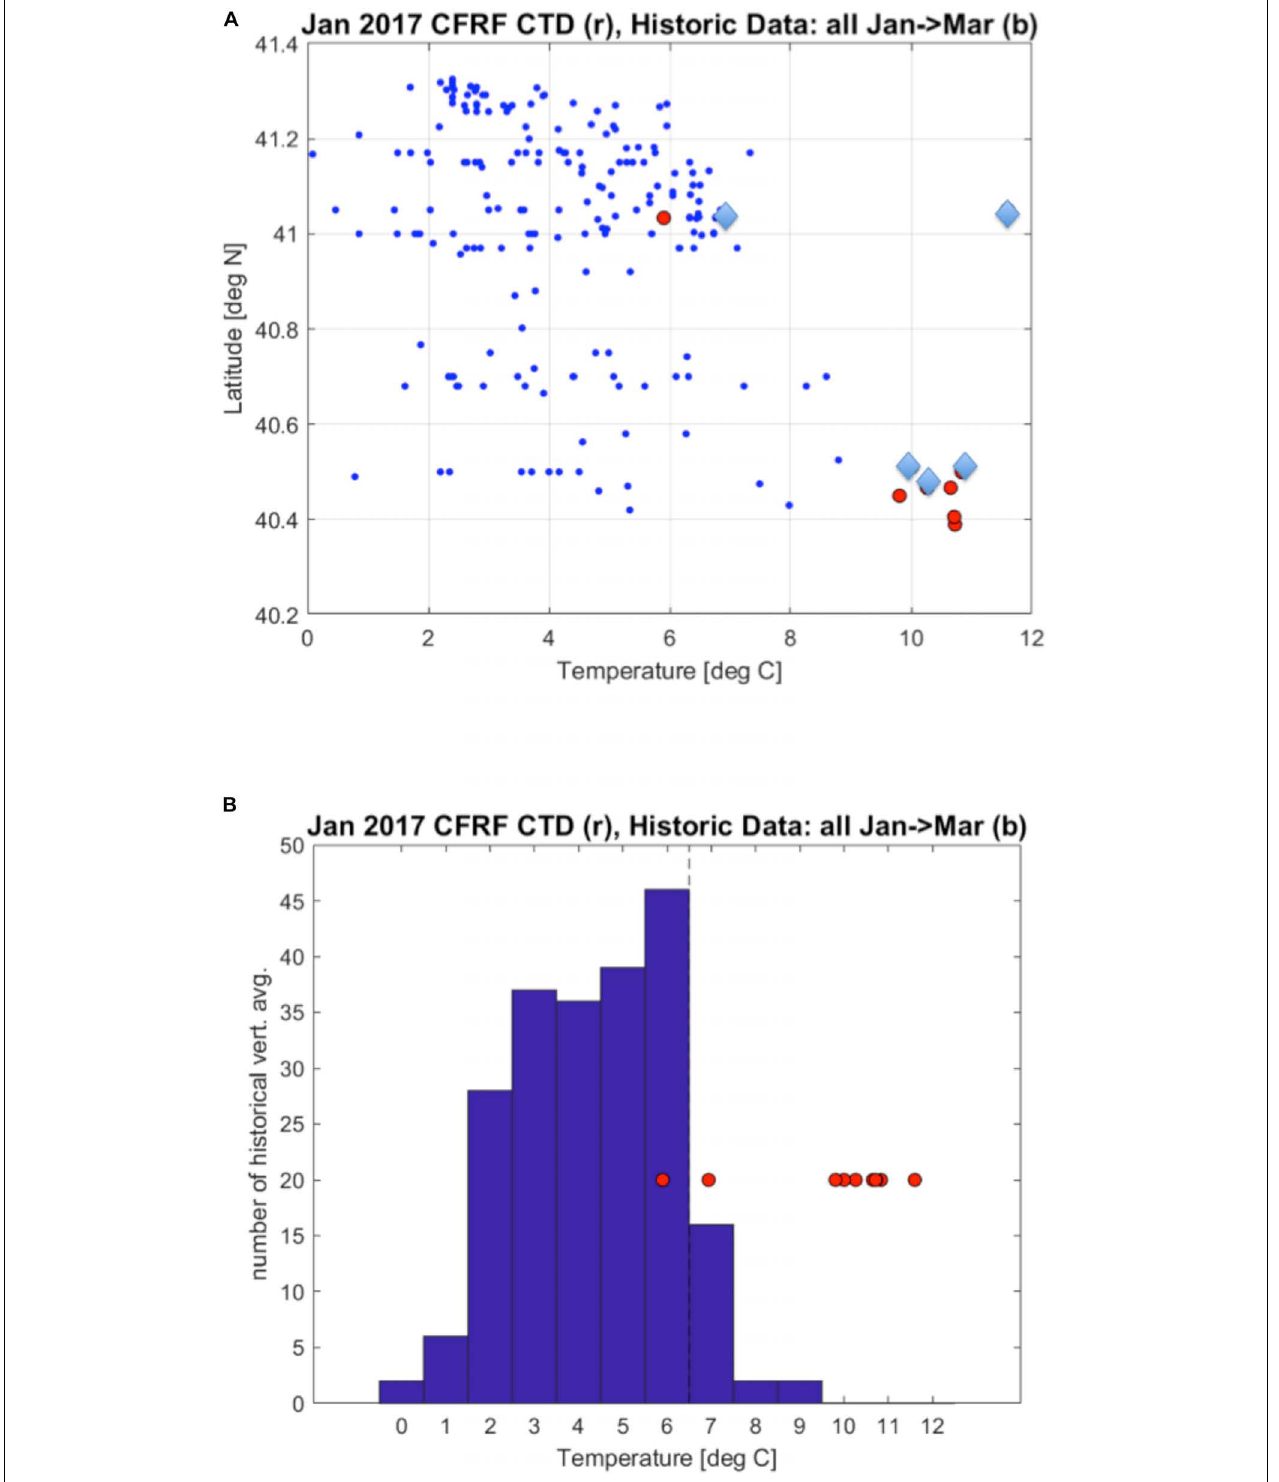
FIGURE 3 | (A) Latitudinal distribution of historical depth averaged temperature (blue circles) and January 2017 (red circles) from the Shelf Research Fleet. Values from January 2017 for which the positions are uncertain are denoted by the blue diamonds. (B) A histogram of historical depth-averaged temperatures compared to depth averaged values from January 2017 (red circles). The dashed line indicates the 90th percentile for the temperature in January–March for the historical data.